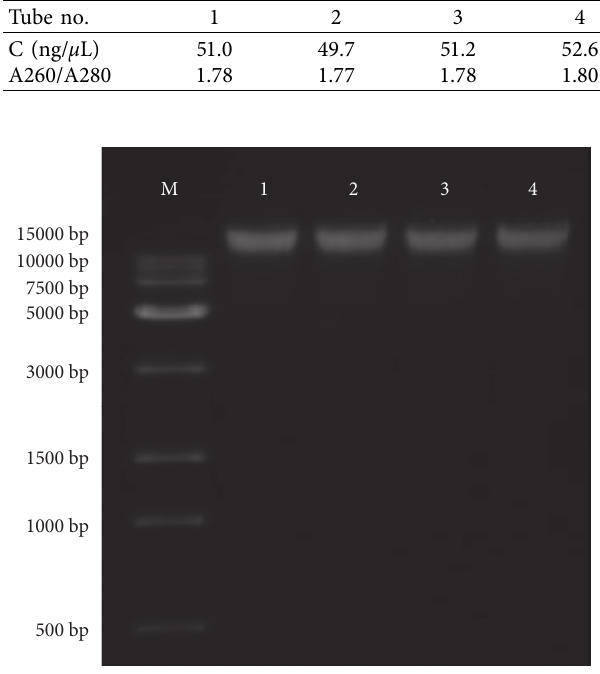
Figure 1: Agarose gel electrophoresis analysis of the genomic DNA of C. sakazakii . M , trans15K DNA marker; lanes 1–4, genomic DNA of C. sakazakii .